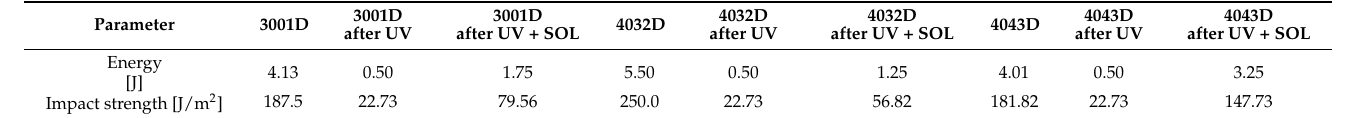
Table 4. Values of energies and impact coefficients for samples 3001D, 4032D and 4043D.